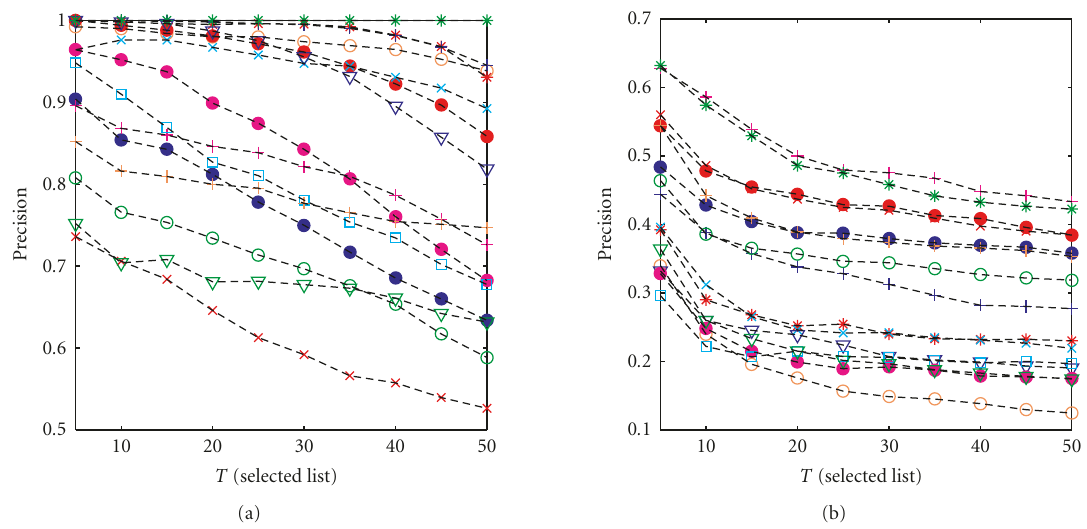
Figure 9: The Precision index of all the preassigned image categories (following the same class labeling as provided in Figure 6), as a function of the selected list T of images for (a) the cognitive dependent scheme and (b) the machine-vision-based methodology.